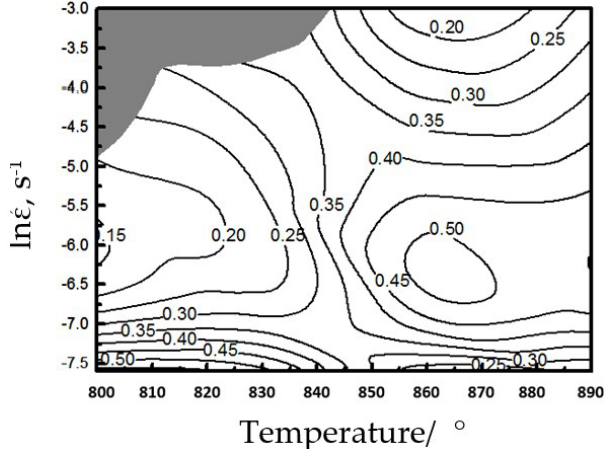
Figure 10. Processing maps for the Ti–6Al–4V alloy.